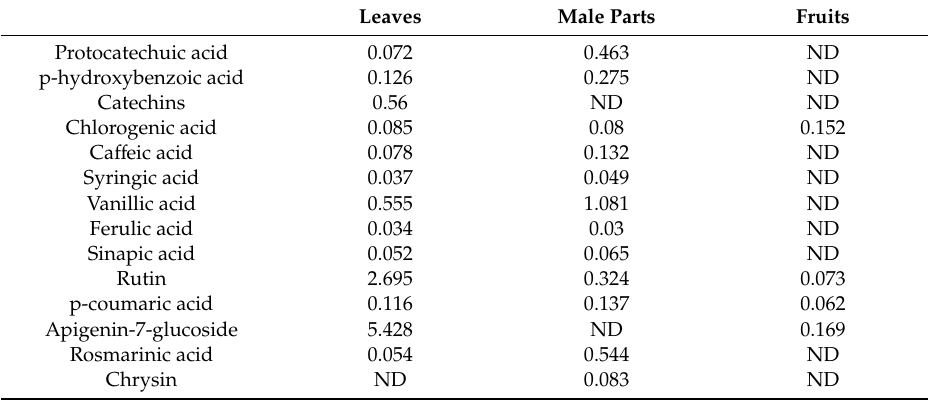
Table 3. Individual polyphenolic compounds (mg/g) in H. thebaica leaves, male parts and fruits. Leaves Male parts Fruits